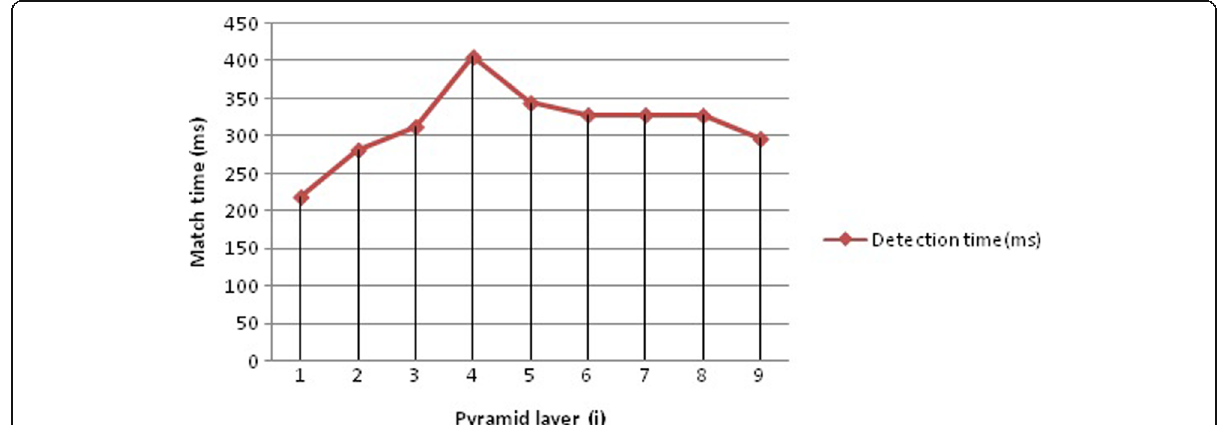
Fig. 8 Correspondence diagram between pyramid layer number and feature detection time